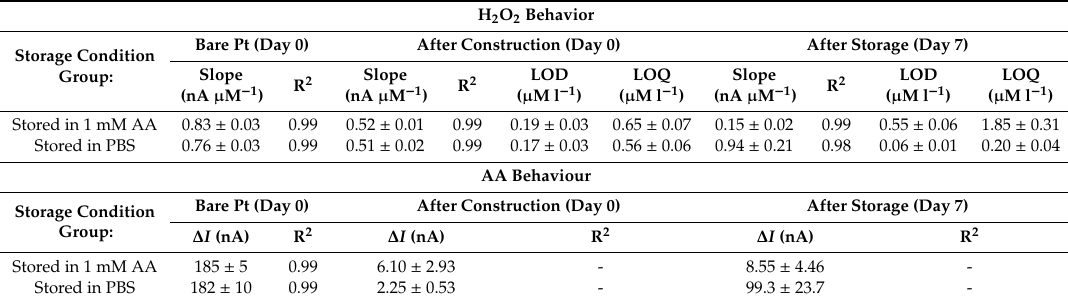
Table 1. Descriptive parameters of the behavior of groups of sensor against reporter molecule H 2 O 2 and ascorbic acid (AA). R-squared (R 2 ) evaluates the goodness of fit of the linear regression of current registered during calibration, when a bad fitting of linear model occurred R 2 is not reported. LOD and LOQ mean limit of detection and limit of quantification, respectively. Di ff erent groups of sensor (n = 4) were assayed for H 2 O 2 and AA before and immediately after the treatment with Chemiplus 2DS HB, then stored in presence (stored in 1 mM AA) or not (stored in PBS) of AA for 7 days under potential ( + 700 mV vs. Ag / AgCl) and subsequently recalibrated. Calibration plot for H 2 O 2 behavior is reported in Figure S3 of Supplementary